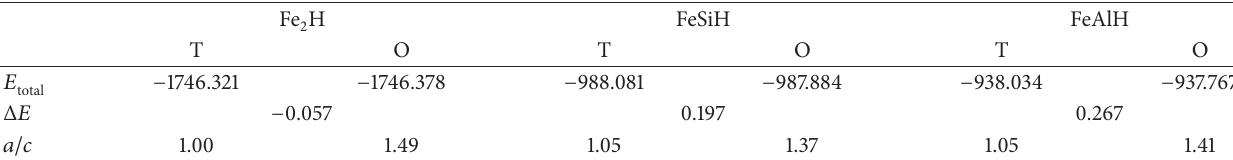
Table 2: Calculated results of total energy ( 𝐸 distortion ( 𝑎/𝑐 ) in unit cells, eV.